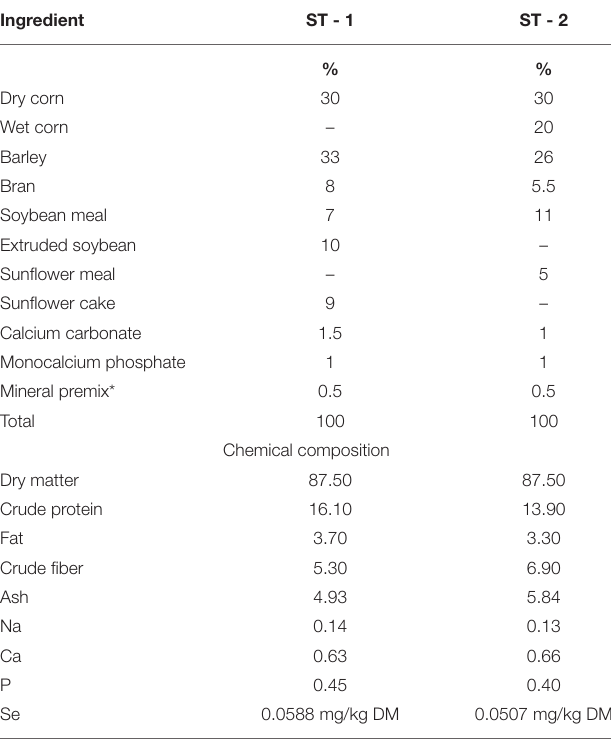
TABLE 1 | Ingredients and chemical composition of the experimental diets. Ingredient ST - 1 ST - 2